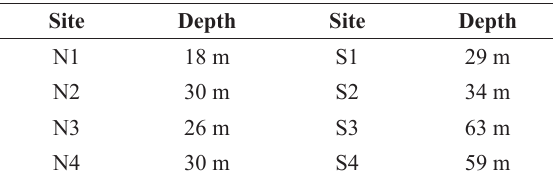
Approximate depth of the onset of the thermocline at different sites and seasonal periods. Sites number 1 and 2 were sampled during the period of maximal precipitation, while sites number 3 and 4 were sampled during the period of minimal precipitation.